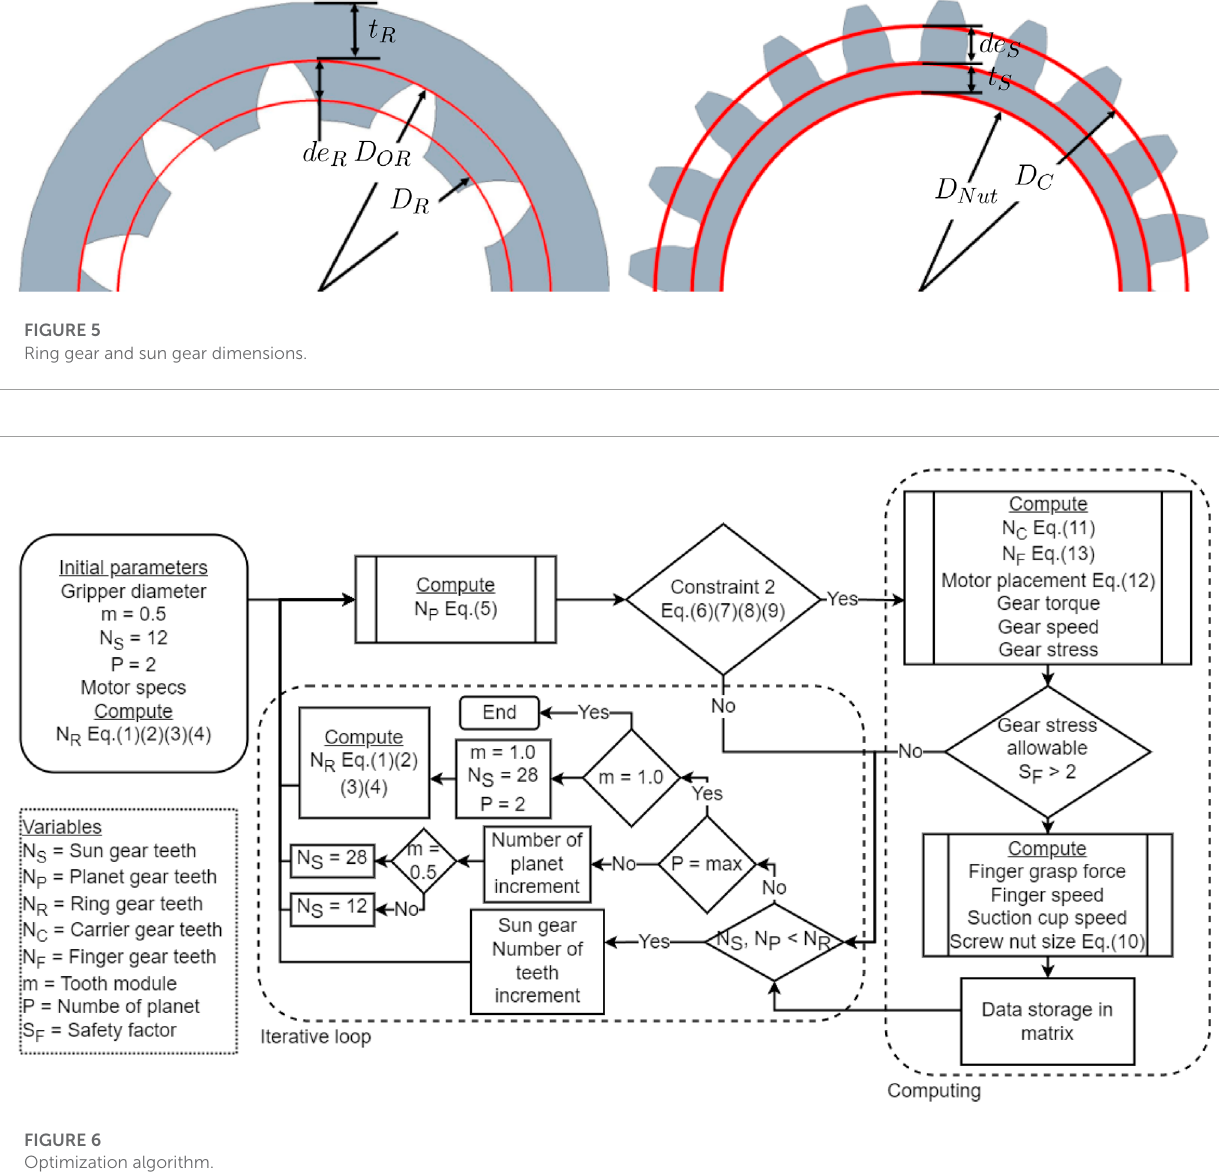
FIGURE 6 Optimization